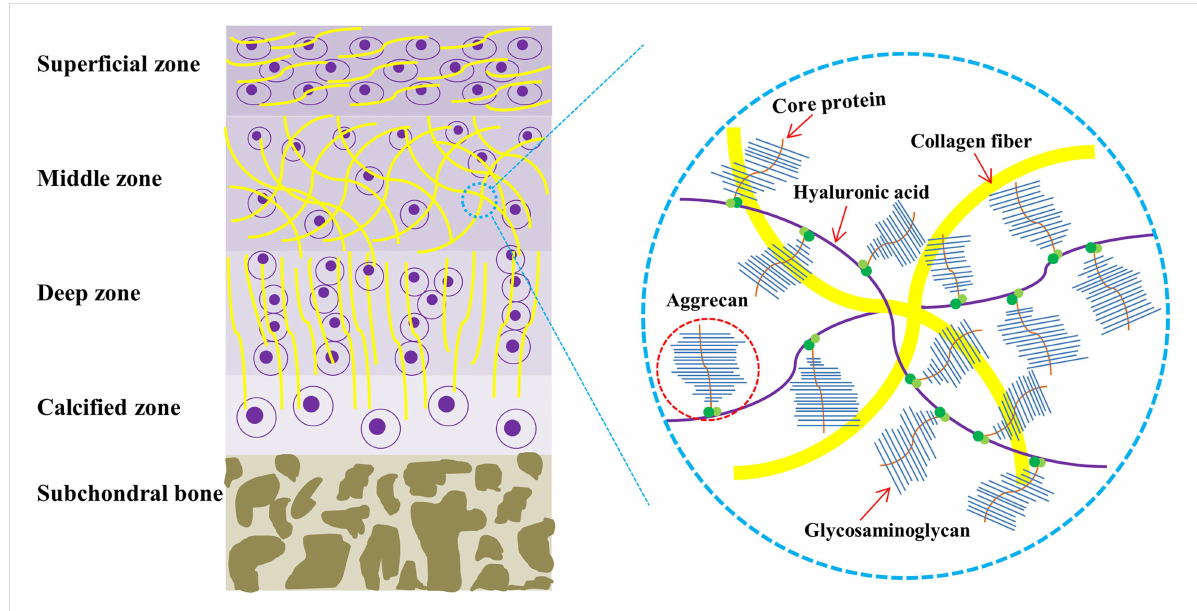
Figure 2: Simplified graphical representation of a cross section of articular cartilage and its associated molecular components. Articular cartilage is normally divided into four distinct regions (the superficial, middle, deep, and calcified zones) visually characterized by the orientation of the collagen fibrils and chondrocyte